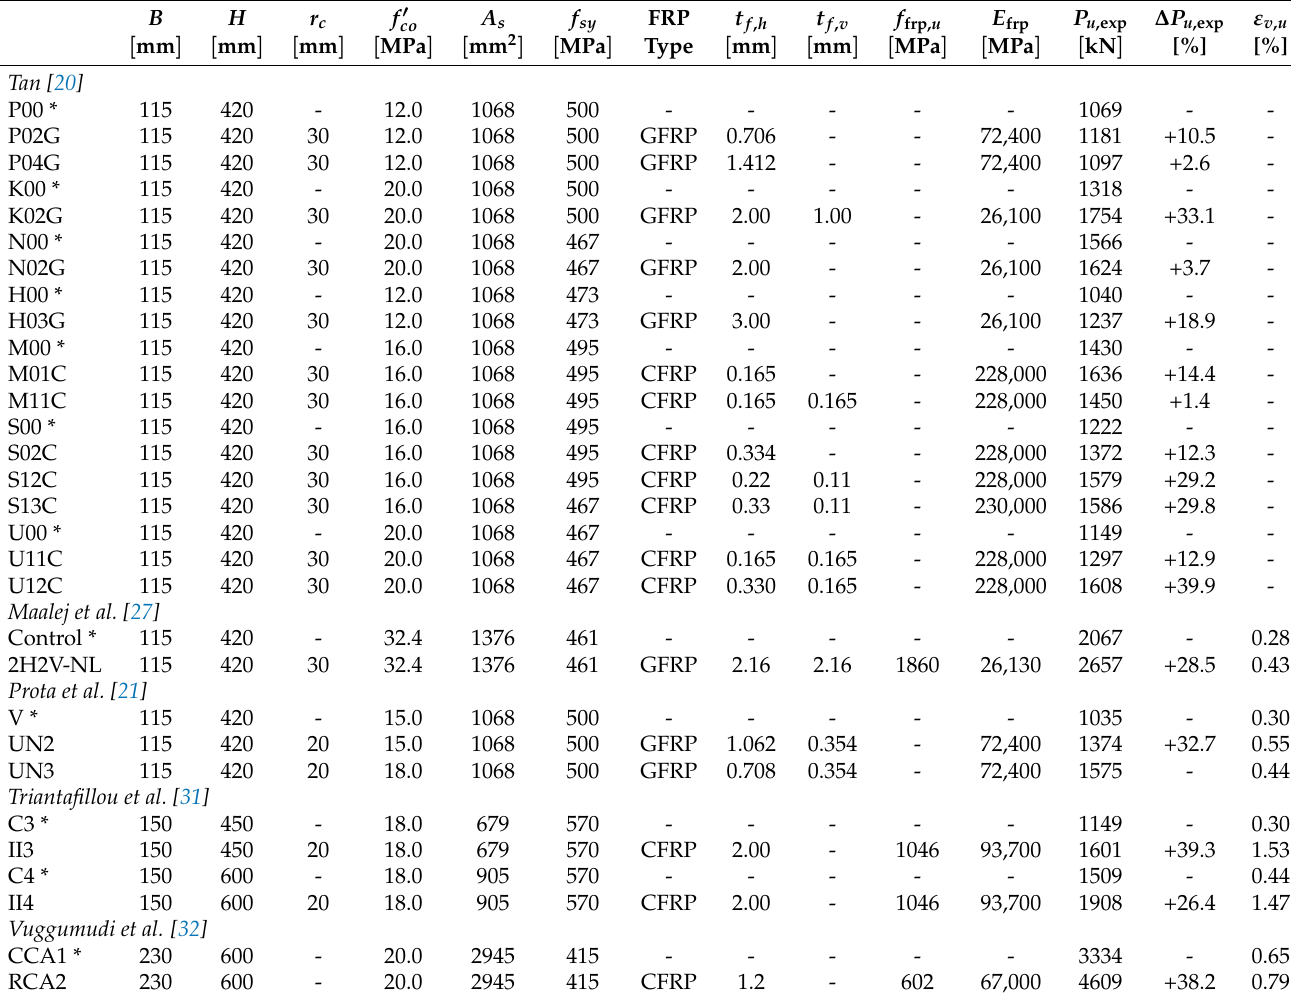
Table 2. Existing test results of FRP-confined wall-like columns